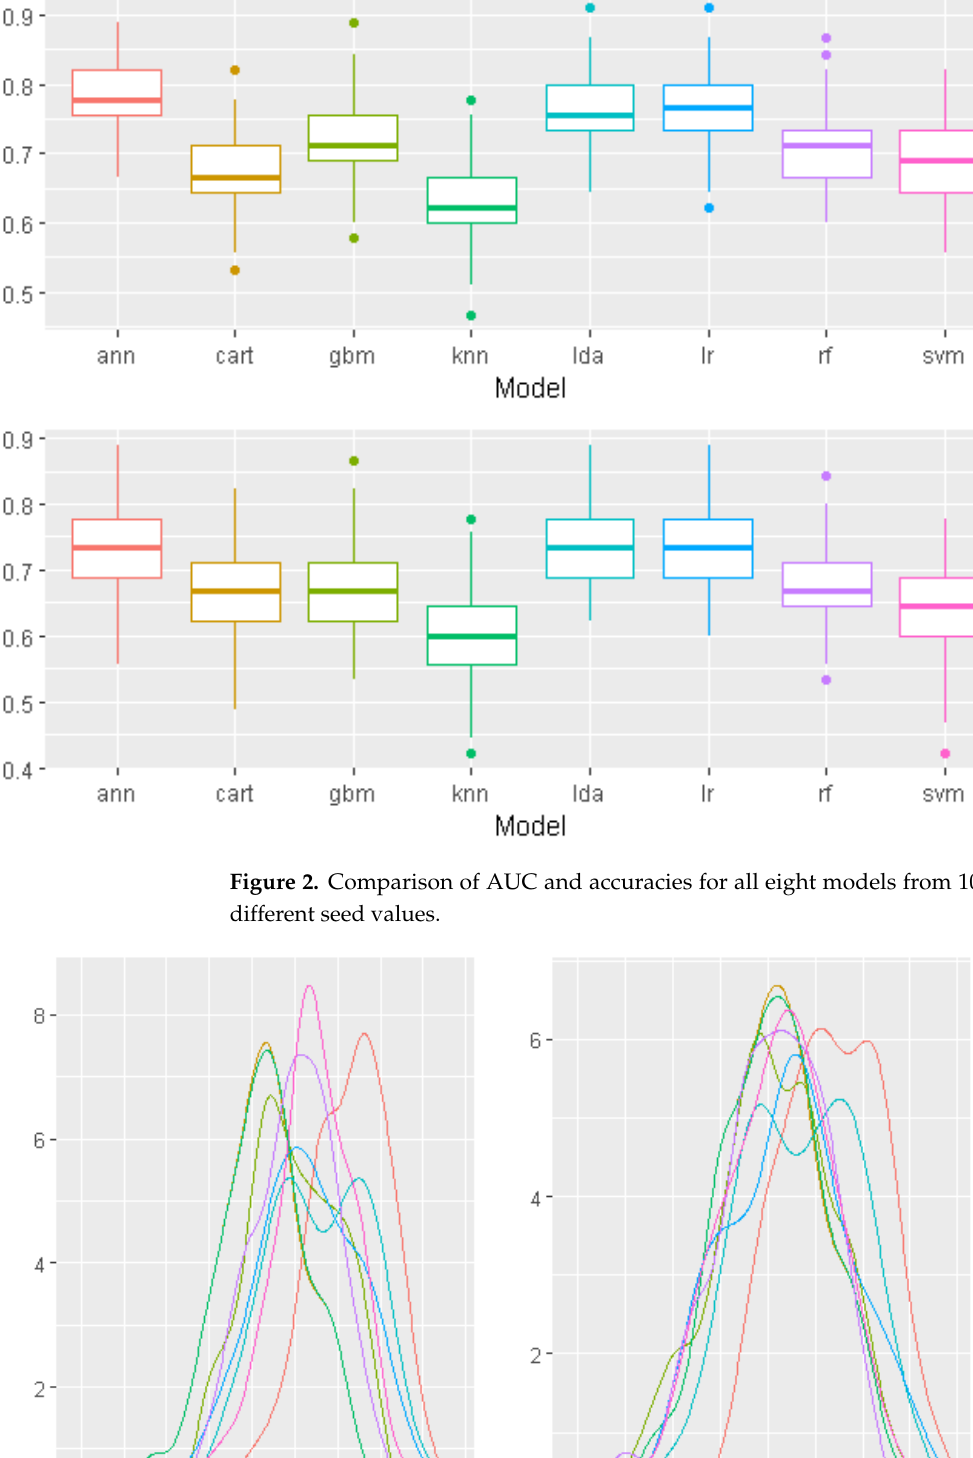
Figure 3. AUC and accuracy density distributions of compared models.